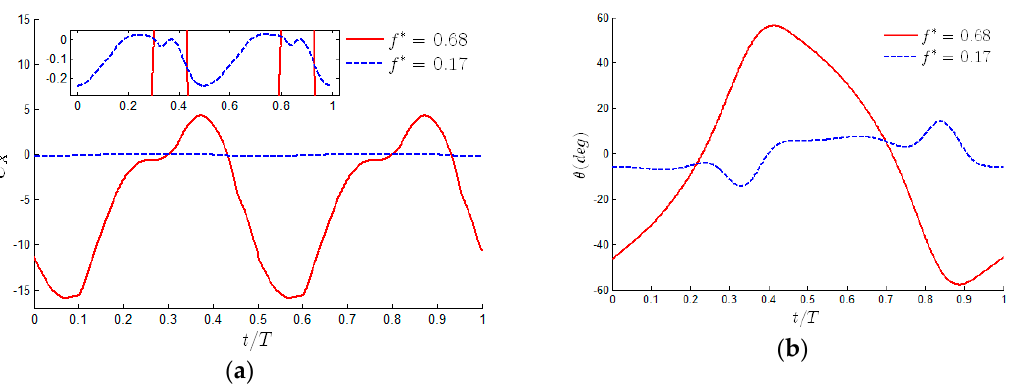
Figure 9. Evolution of ( a ) the thrust coe ffi cient and ( b ) pitching profile for k ∗ = 0.09, y 0 = 0.2, and f ∗ = 0.17 − 0.68 .